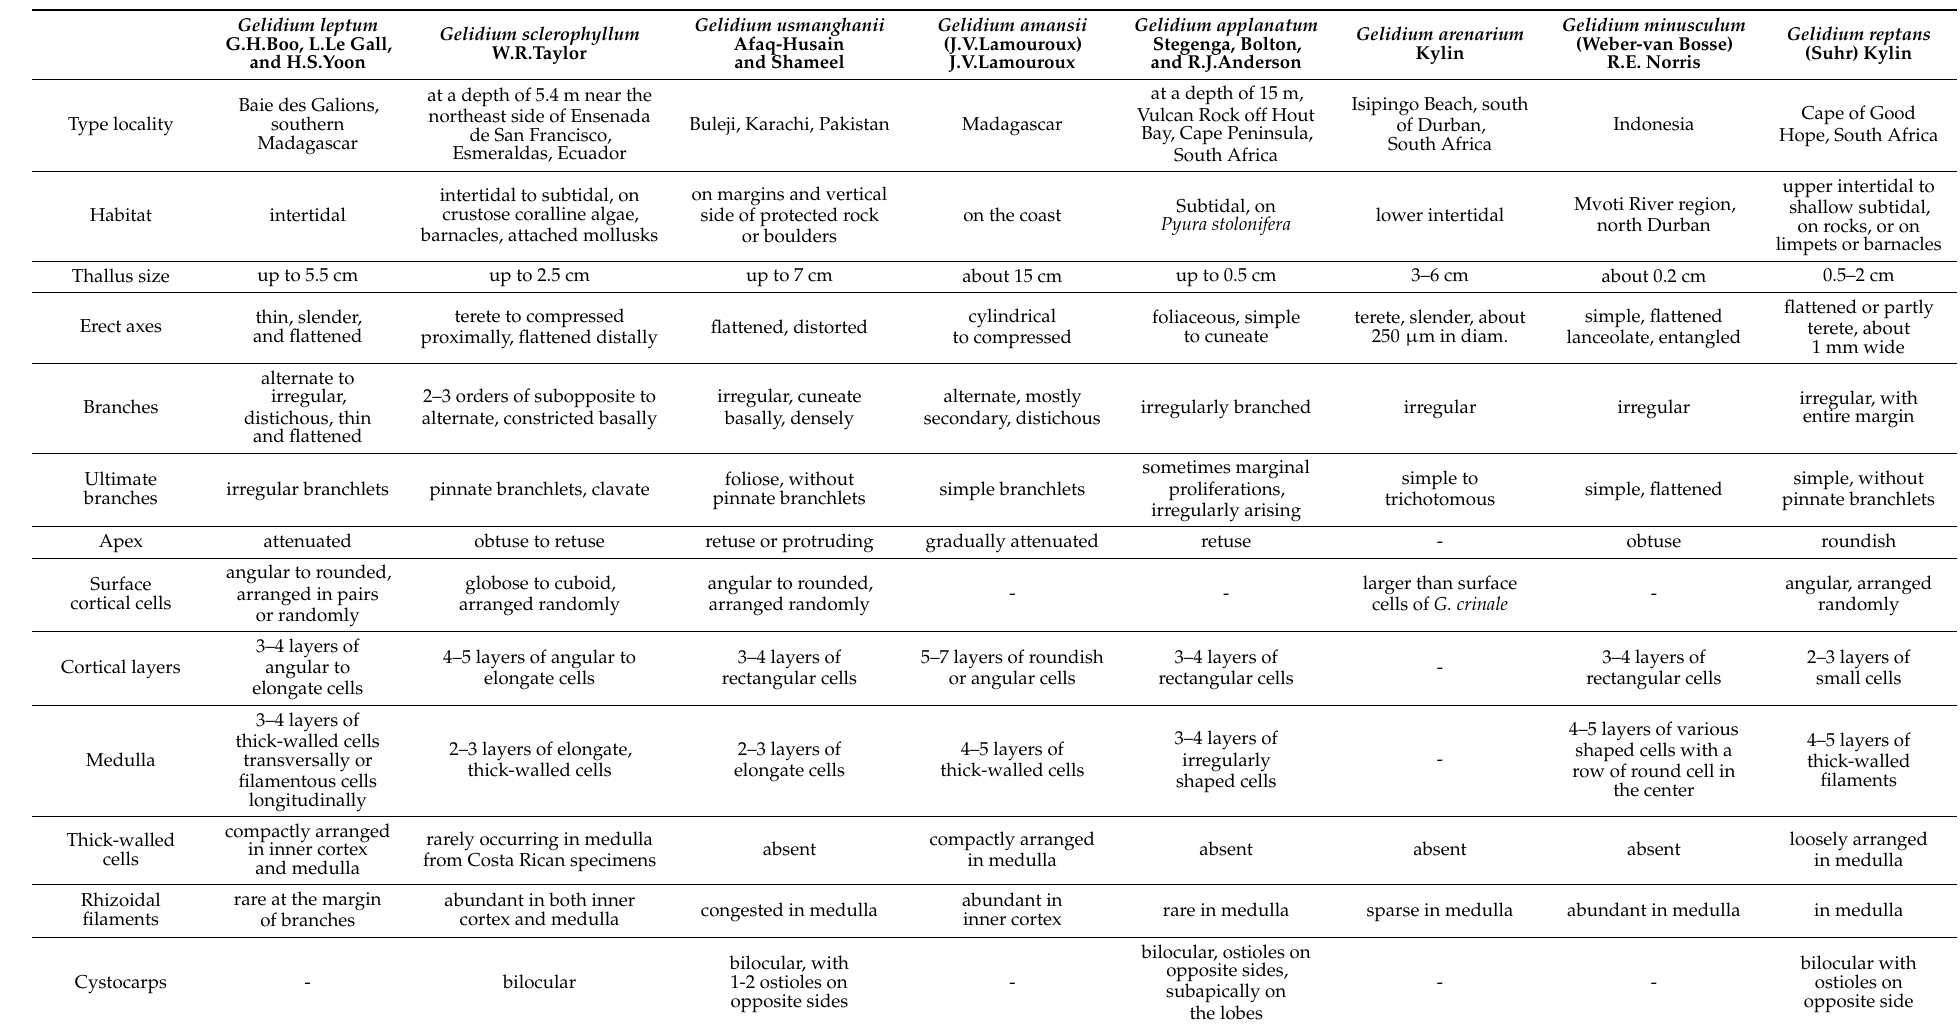
Table 2. Characteristics of Gelidium species from southern Madagascar and morphologically similar